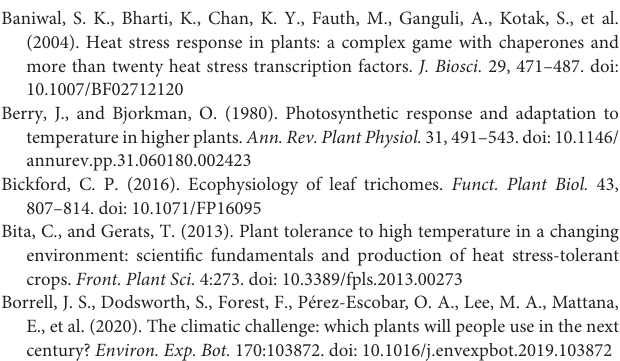
Supplementary Figure 1 | MDA content of C. crassifolia and C. cadmia grown under three different temperatures. Values are the means ± standard error ( n = 5 plants). Different letters indicate significant differences based on two-way ANOVA followed by Tukey multiple comparisons ( P ≤ 0.05). Supplementary Table 1 | The unigene annotations in the KEGG pathway database. Supplementary Table 2 | Primer sequences for gene expression